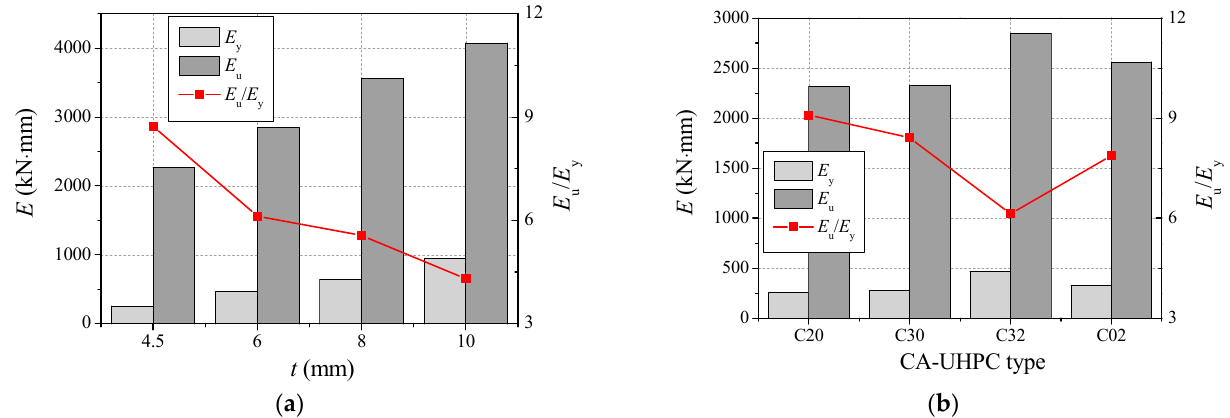
Figure 12. The energy dissipation capacity of CA-UHPCFST members. ( a ) The effect of steel tube thickness; ( b ) the effect of CA-UHPC type.